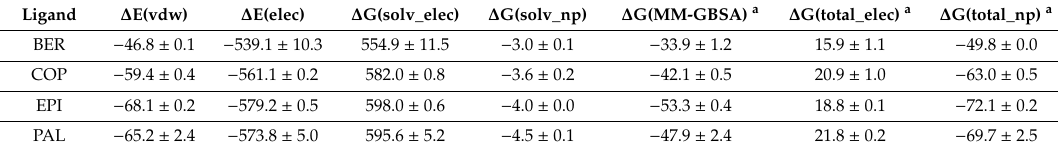
Table 1. MM-GBSA binding free energies and their components computed using the bsc0 force field [23]. Units: kcal / mol.